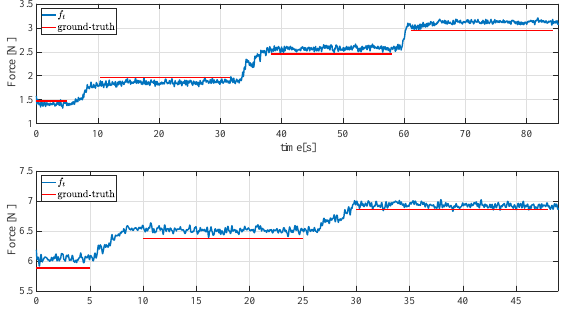
Figure 17. Second experiment: Assessment of the reconstruction of the grasped object weight—second grasp.